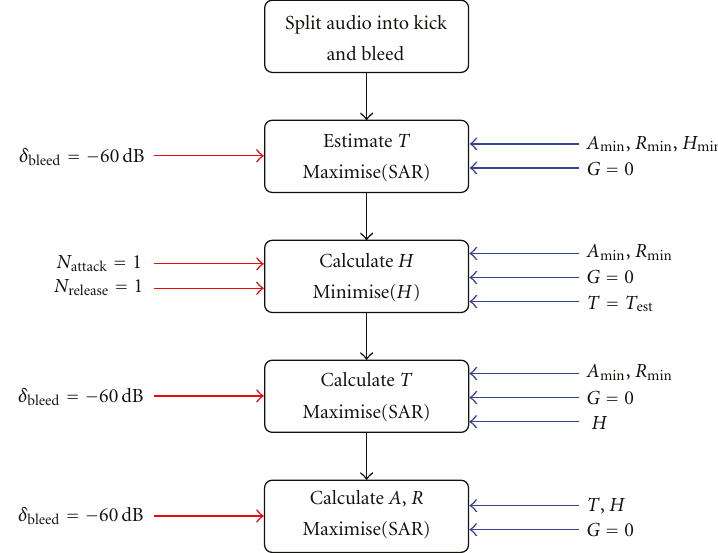
Figure 3: Automatic noise gate flow chart.